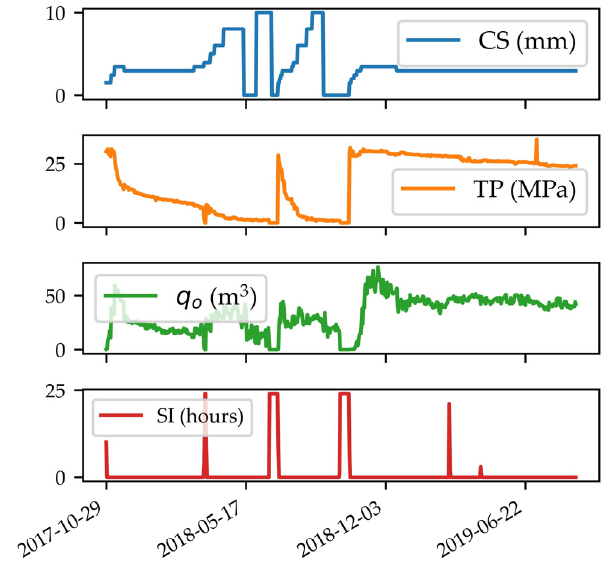
Figure 3. Typical production history in X well block.